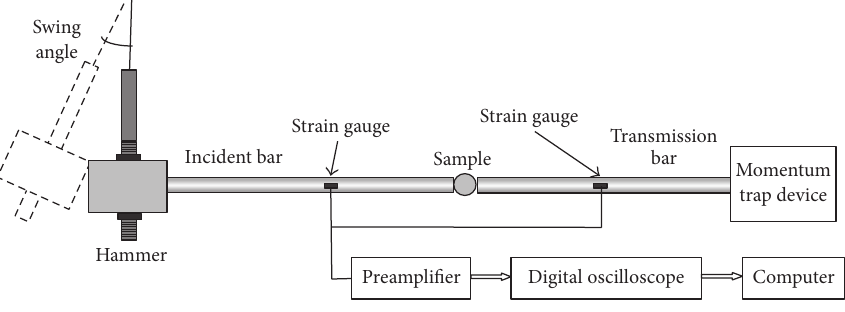
Figure 6: The pendulum hammer-driven SHPB experimental apparatus.